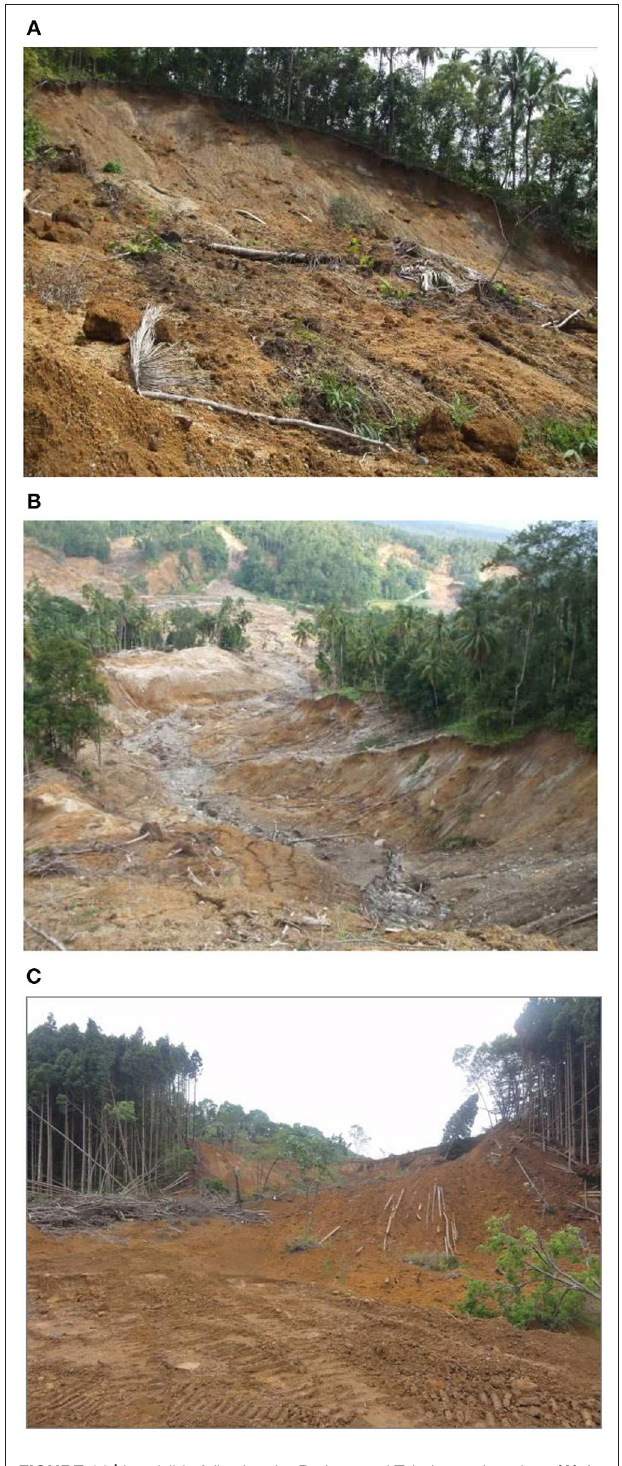
FIGURE 14 | Landslide following the Padang and Tohoku earthquakes. (A) A slip-circle landslide failure at Pulau air village, Pariaman. (B) An infinite-slip slope landslide at Cumanak village, Pariaman. (C) Earthquake-induced landslide at